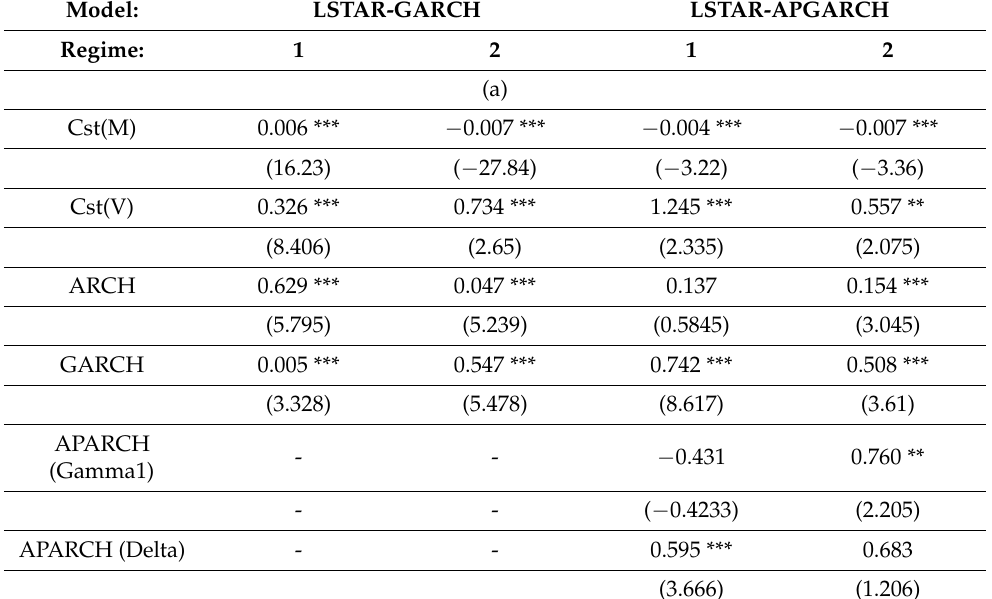
Table 6. (a) Model Estimation Results for BDI Daily % Returns; (b) Model Estimation Results for VIX Daily % Returns; (c) Model Estimation Results for MSCI Daily %